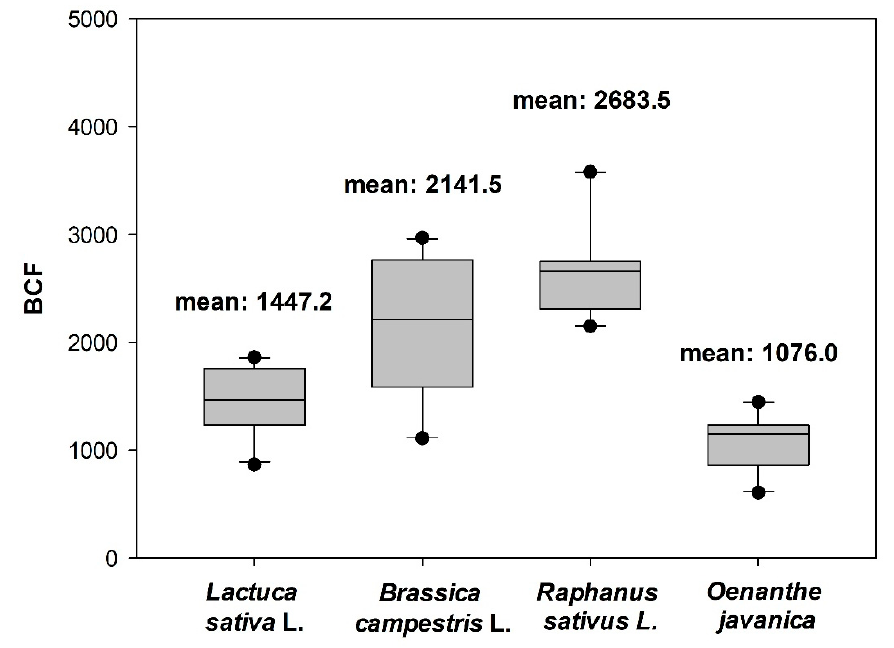
Figure 2. Box-and-whisker plot of bioaccumulation factors of four species in artificial solutions with different initial uranium concentrations (15, 30, 80, 120, 180, and 450 µ g/L) after 72 h of treatment.